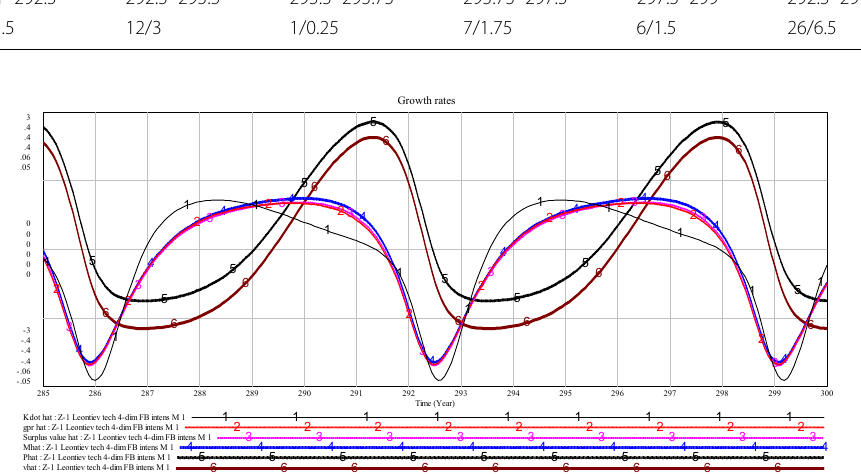
Fig. 11 The growth rates of economic indicators in industrial cycles resulting from the first AHB in L-2: for investment (1), for profit rate (2), for surplus value (3), for profit (4), for net output (5), for employment ratio (6), years